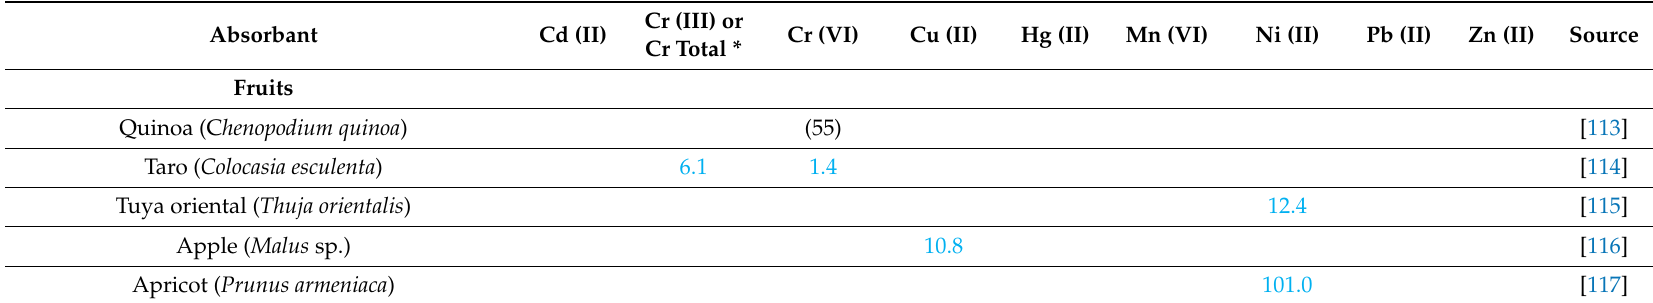
Table 3. Heavy metal removal potential using terrestrial plant-derived materials in the developing world, in mg / g or (% removal) (Peruvian studies in black color). SNS stands for “species not